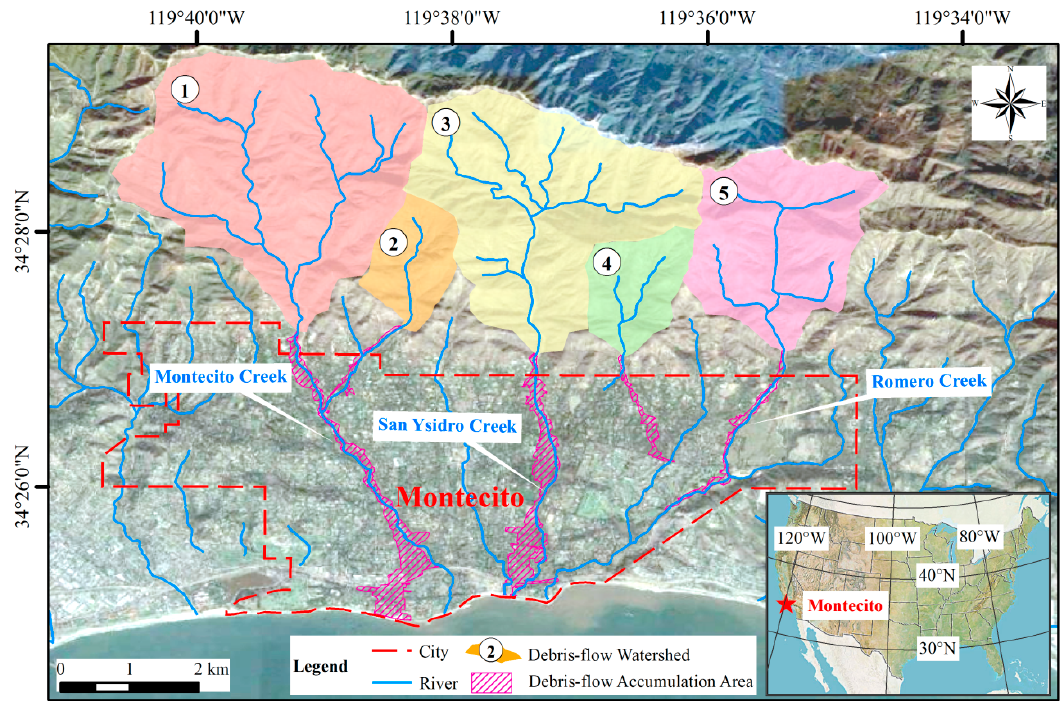
Figure 2. Debris-flow watersheds and debris-flow accumulation area around Montecito.